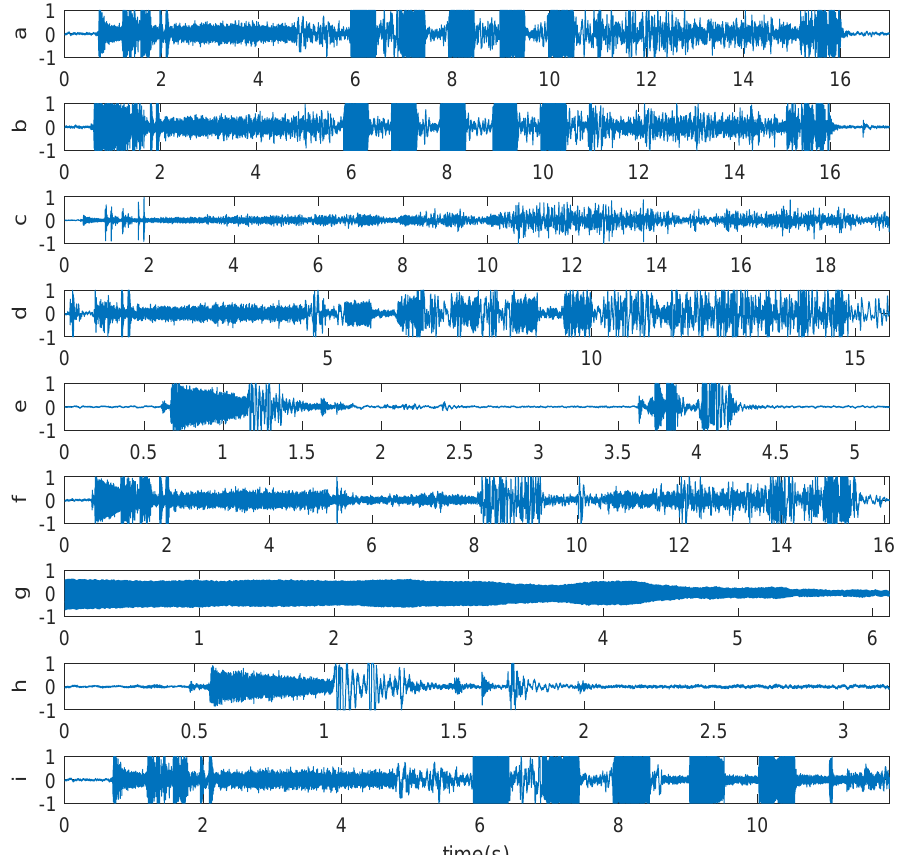
Figure 2. Time-domain waveforms of sound signals from Type-a to